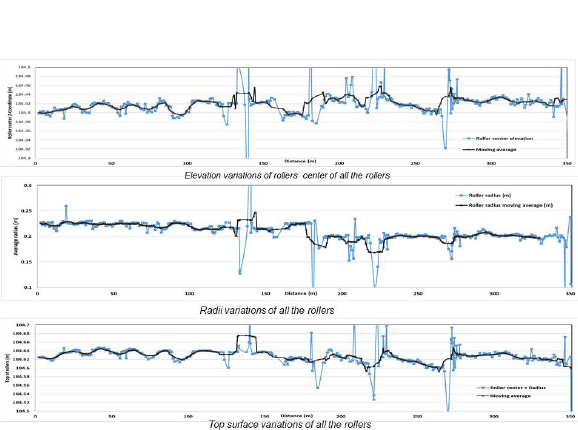
Figure 20. A plot showing the centerline of all rollers before filtering the erroneously located